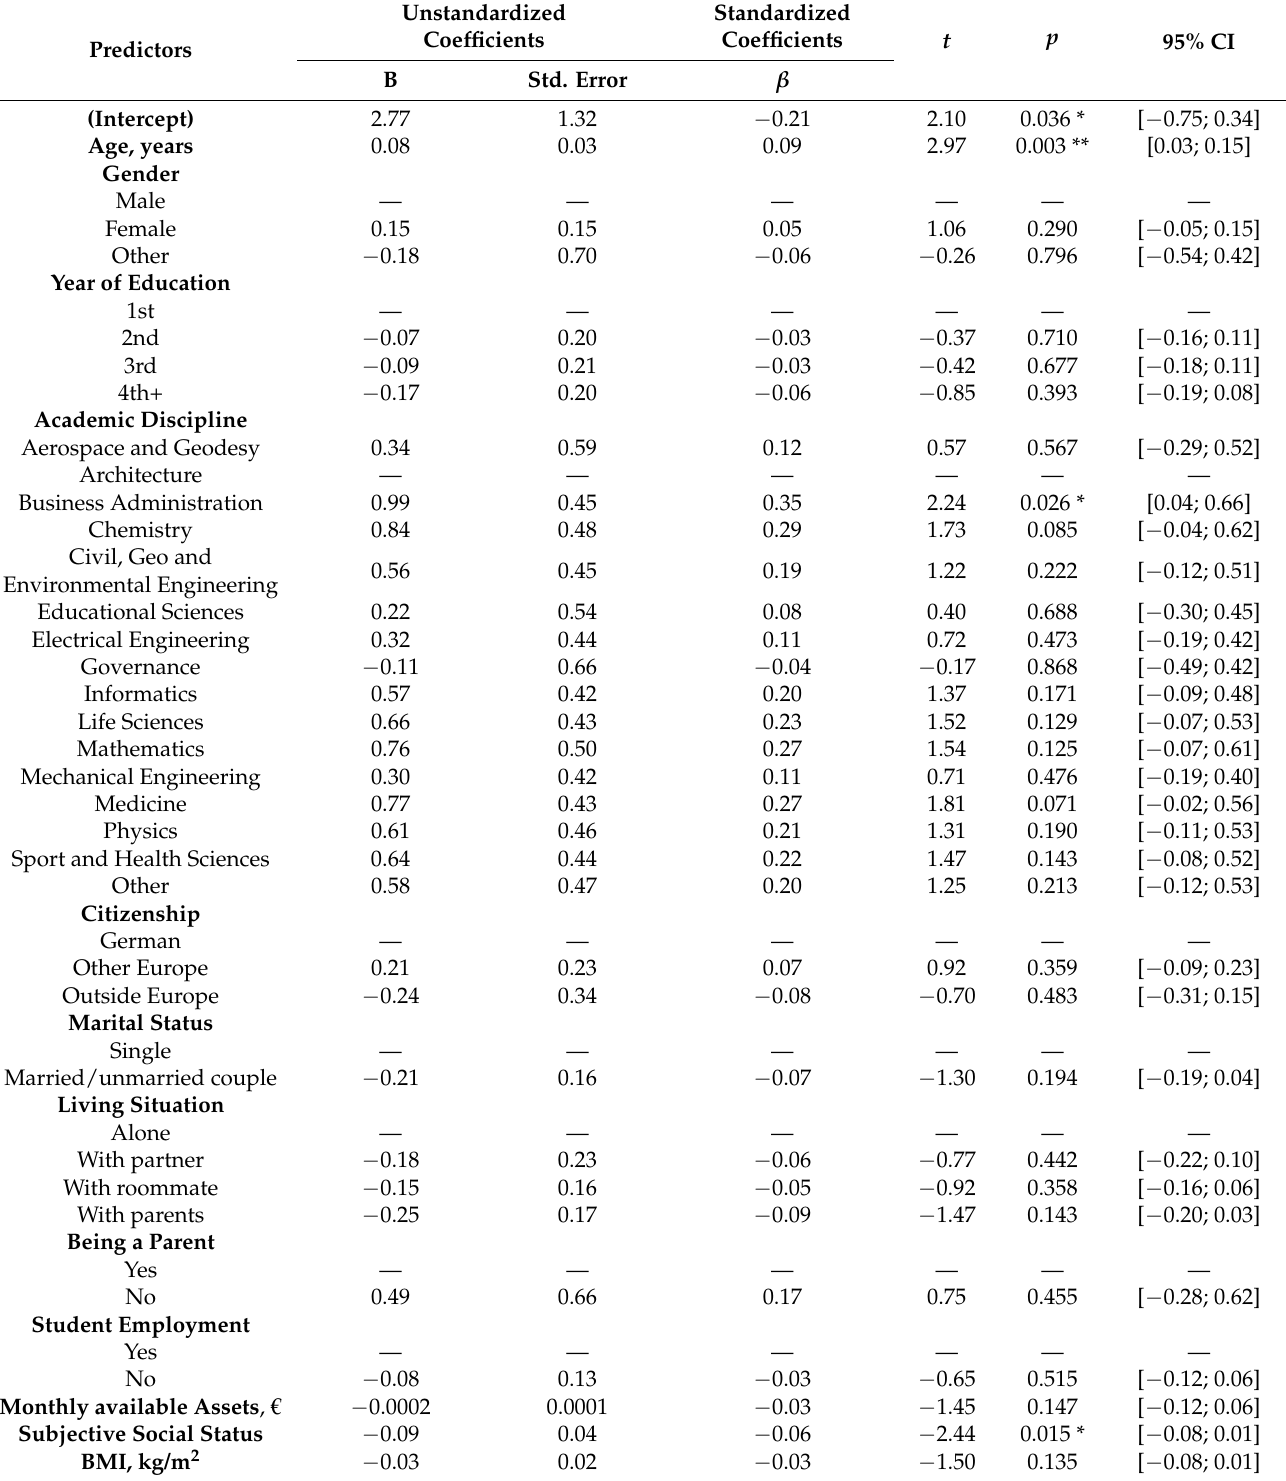
Table A1. Multiple regression results with sleep quality as the dependent